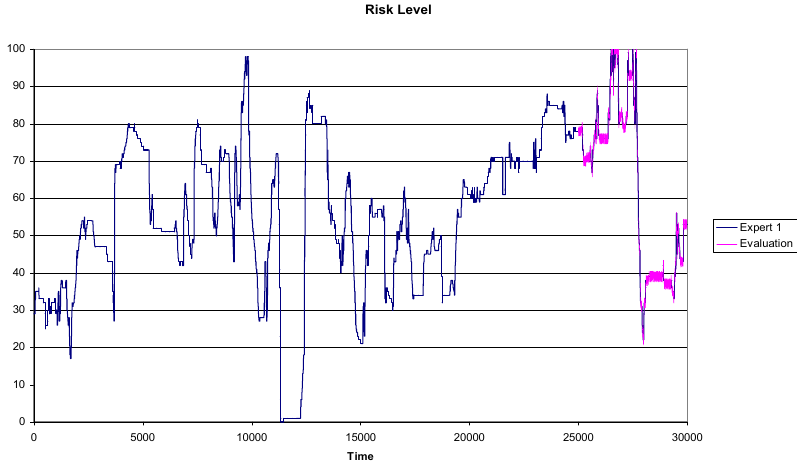
Table 5. Results for Expert 1 with n = 25,000; n = 20,000; n = 15,000 and n = 10,000. n = 25,000 n = 20,000 n = 15,000 n = 10,000 max (abs. error) 1.05 1.28 1.42 1.46 standard dev. 0.35 0.44 0.47 0.51 mean sq. error 0.36 0.55 0.68 0.73